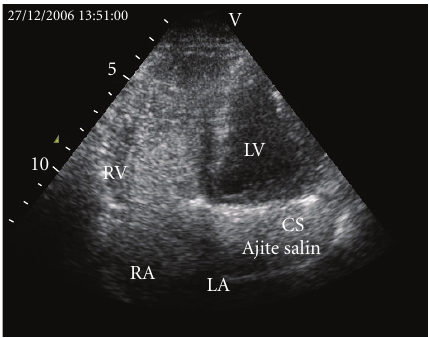
Figure 1: Passage of the contrast into the right atrium via coronary sinus on apical 4 chamber view of transthoracic echocardiography. LA: Left atrium, LV: Left ventricle, RV: Right ventricle, RA: Right atrium; CS: Coronary sinus.